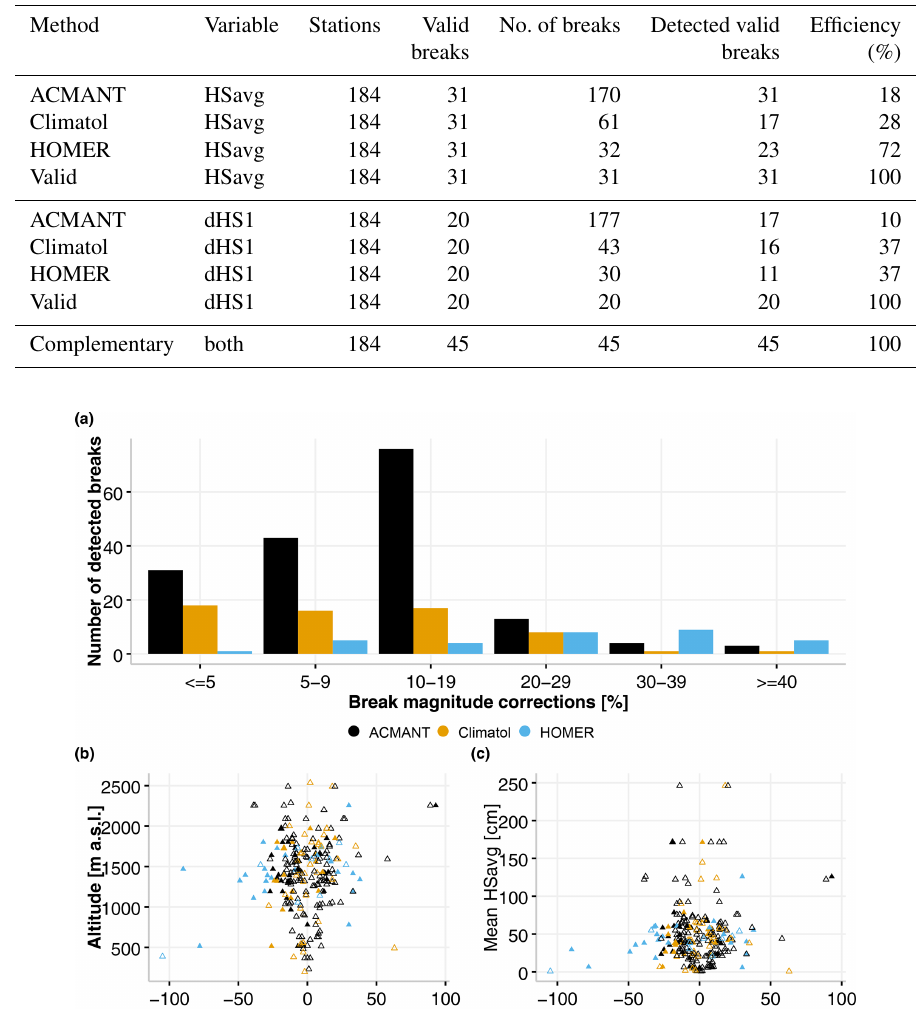
Table 2. Comparison of detected break points for each individual method. A valid break point means it was detected by at least two out of three methods. The complementary category uses break points from both dHS1 and HSavg (six break points are identical).